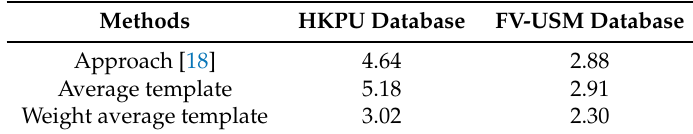
Figure 13. Performance of various methods on the ( a ) HKPU Database and the ( b ) FV-USM Database. Table 1. Equal error rate of various approaches on both datasets.